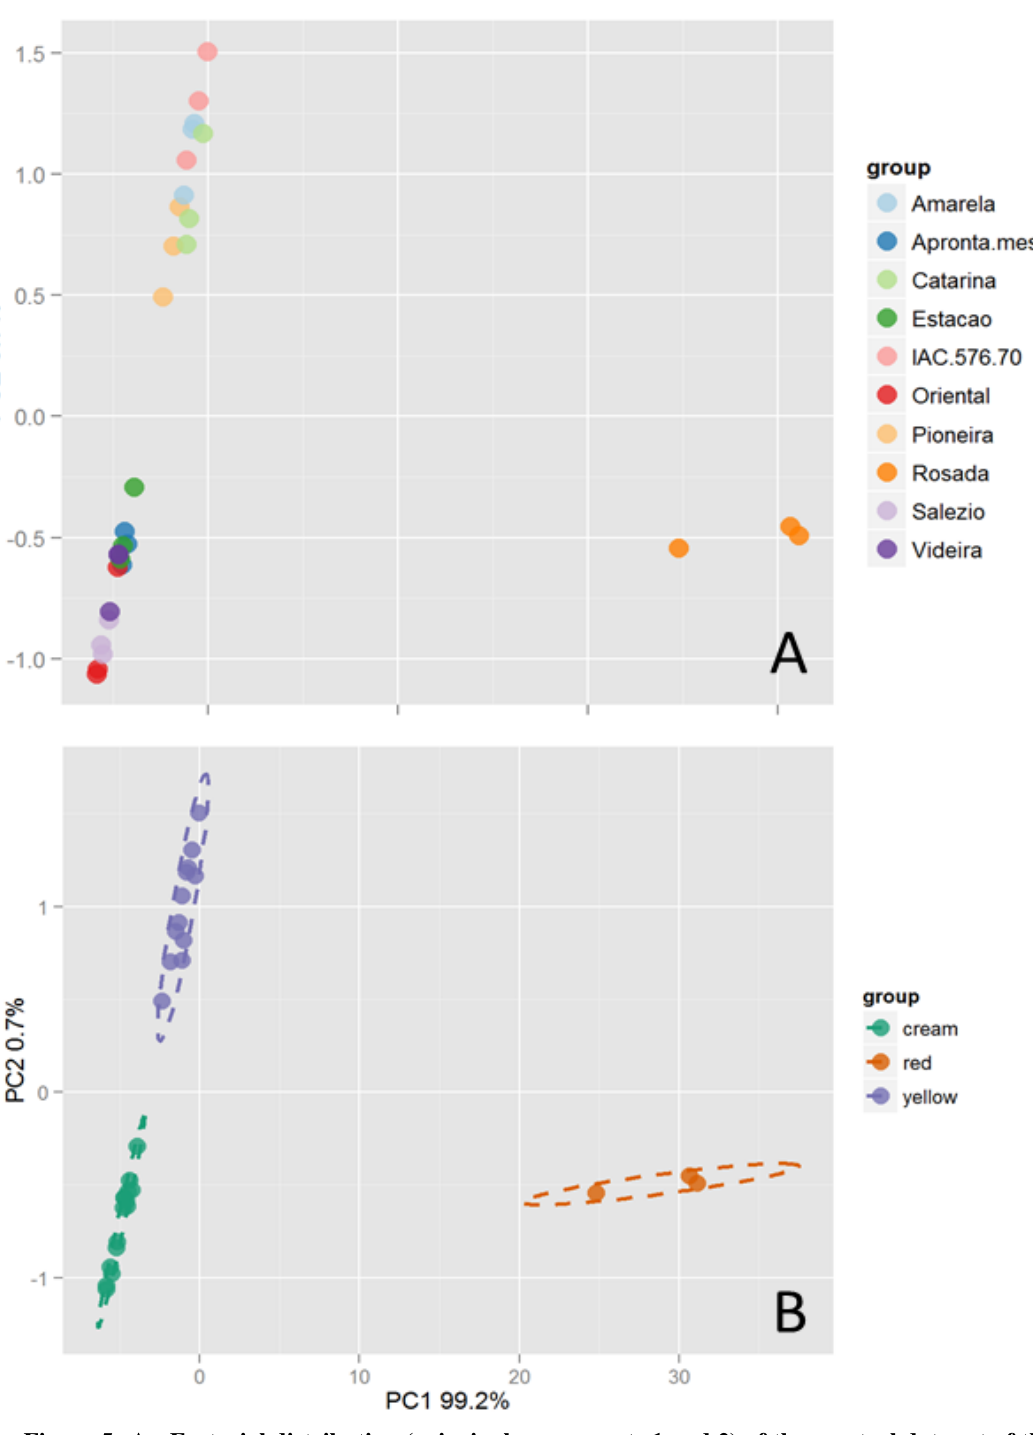
Figure 5: A - Factorial distribution (principal components 1 and 2) of the spectral data set of the fingerprint region of carotenoids (UV-Vis 400-500 nm, acetone: petroleum ether - v/v, 1:1). B - Graphical demonstration according to the root flesh